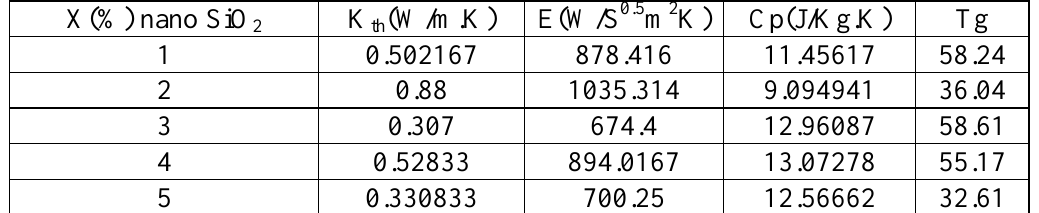
(W/m.K), E(W/S 0.5 m 2 K), Cp(J/Kg.K , Tg) for UP/ nano th